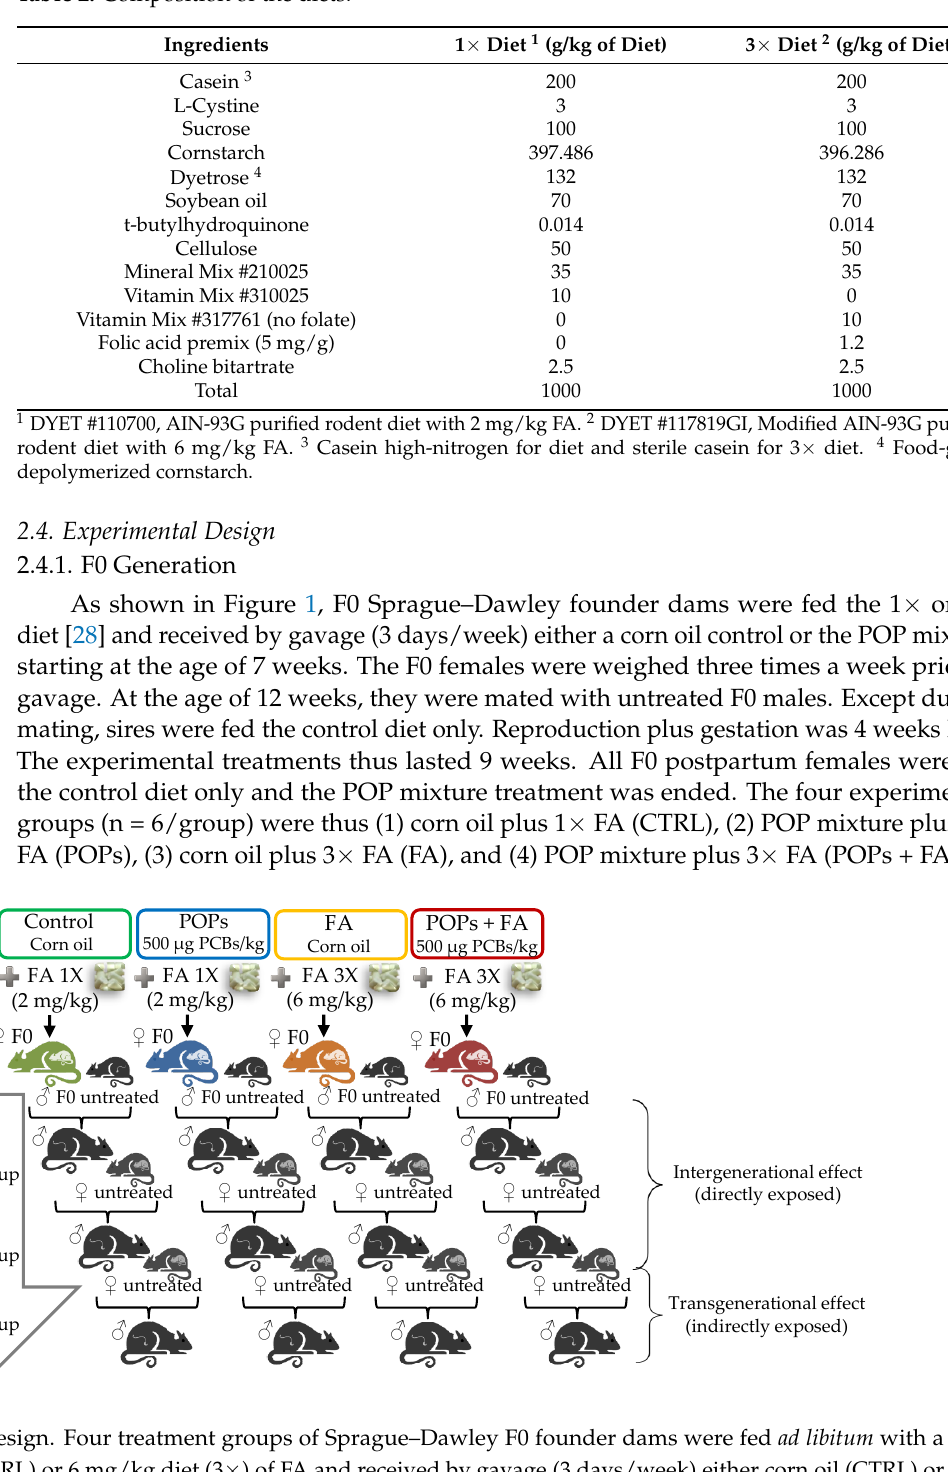
Table 2. Composition of the diets.